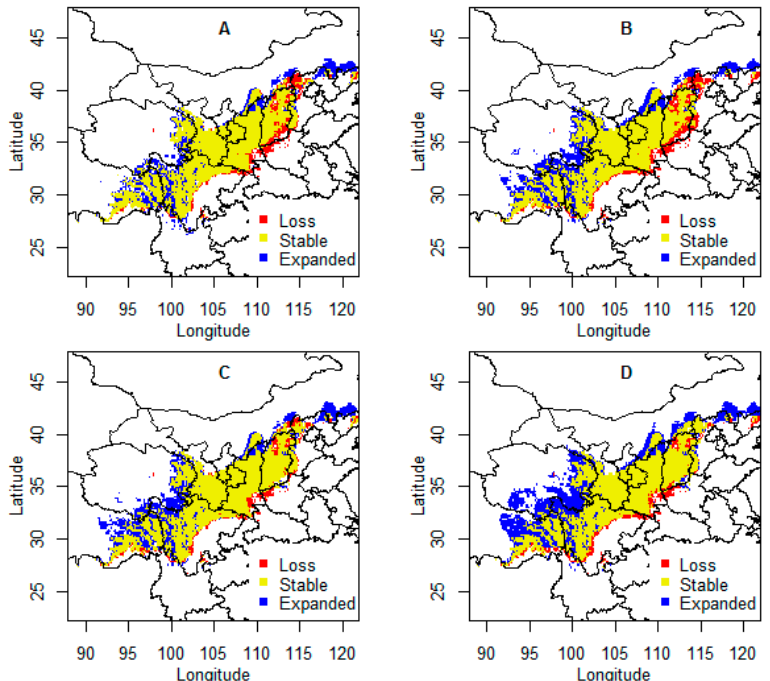
Figure 2. Climate-related range shift in extent and location of Chinese sea buckthorn in China under four climate change scenarios in the 2070s. ( A ) RCP2.6; ( B ) RCP4.5; ( C ) RCP6.0; ( D ) RCP8.5.